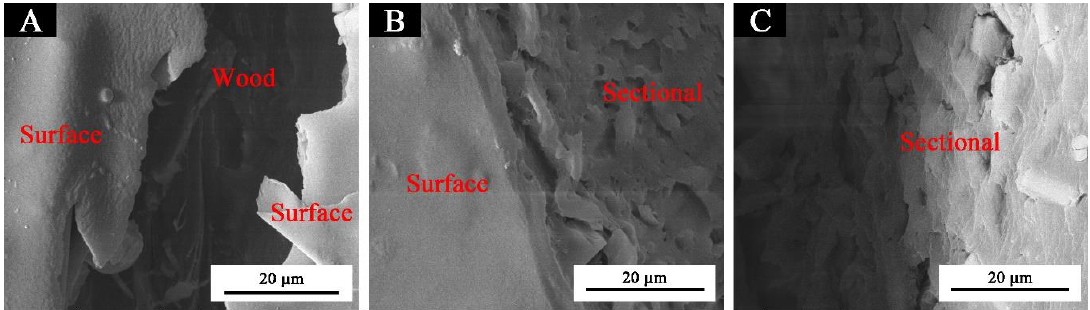
Figure 3. Cross-sectional SEM of the waterborne coating with thermochromic ink and 3.0% of glass fiber powder: ( A ) coating surface and wood, ( B ) surface and section, and ( C ) sectional micrographs.